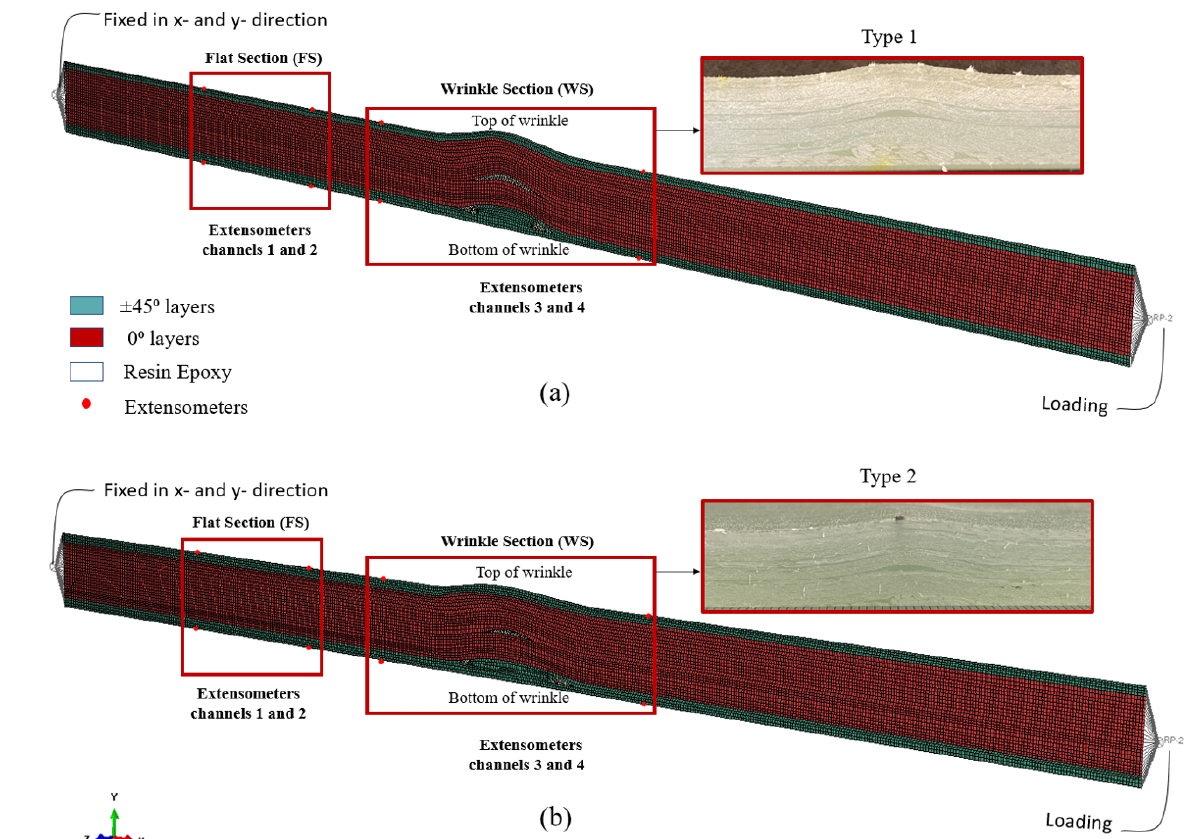
Figure 7. High-fidelity finite element model modelled in a ply-by-ply sequence, with biaxial layers on top and bottom, UD layers in between and resin pocket around the Biax fold and underneath the ply contour of max. amplitude: (a) coupon specimen model for wrinkle type 1 and (b) coupon specimen model for wrinkle type